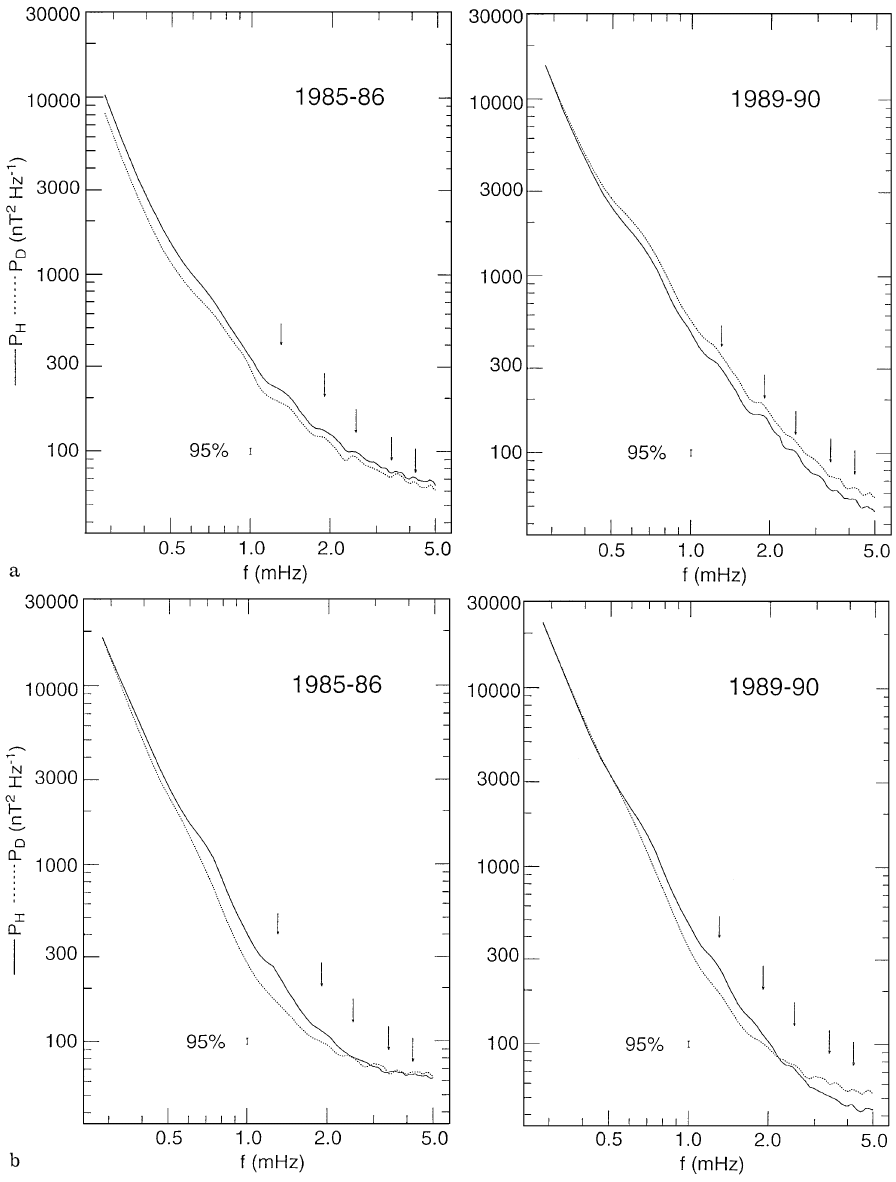
Fig. 1a, b. Power spectra (log ! log scale) of the horizontal components H and D . Arrows identify the cavity-mode frequencies predicted by Harrold and Samson (1992). Bar at 1 mHz corresponds to the 95% confidence interval. a Daytime spectra; b nighttime